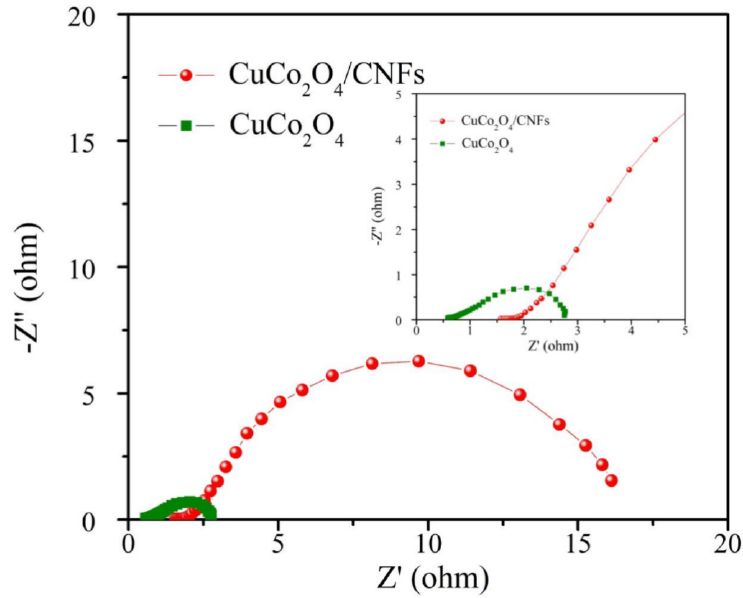
Figure 8. Nyquist plots of CuCo 2 O 4 @CNFs electrode and CuCo 2 O 4 electrode.